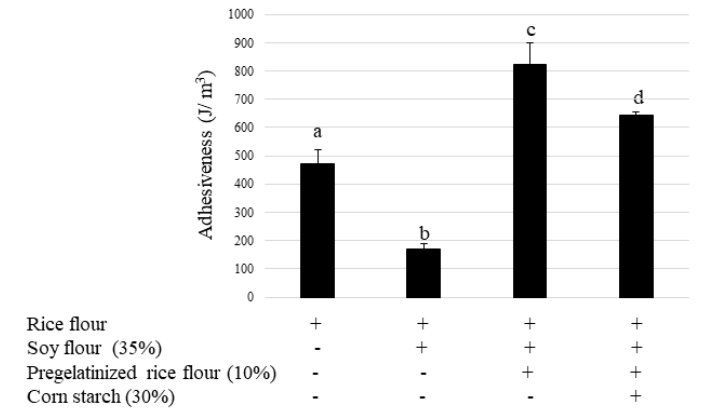
Figure 9. Effects of pregelatinized rice flour and cornstarch on adhesion of bread dough. Data are shown as mean ± SD. Different letters indicate p < 0.05 between groups.